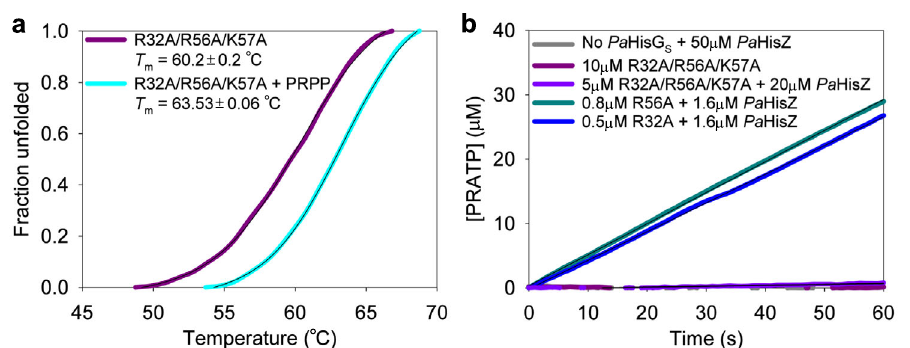
Fig.8|BiochemicalcharacterisationofR32A/R56A/K57A- Pa HisG S .a DSF-based thermal denaturation of R32/R56A/K57A- Pa HisG S . Traces are averages of three independentmeasurements.Linesof best fi tto Eq.(2)areinblack.Source dataare